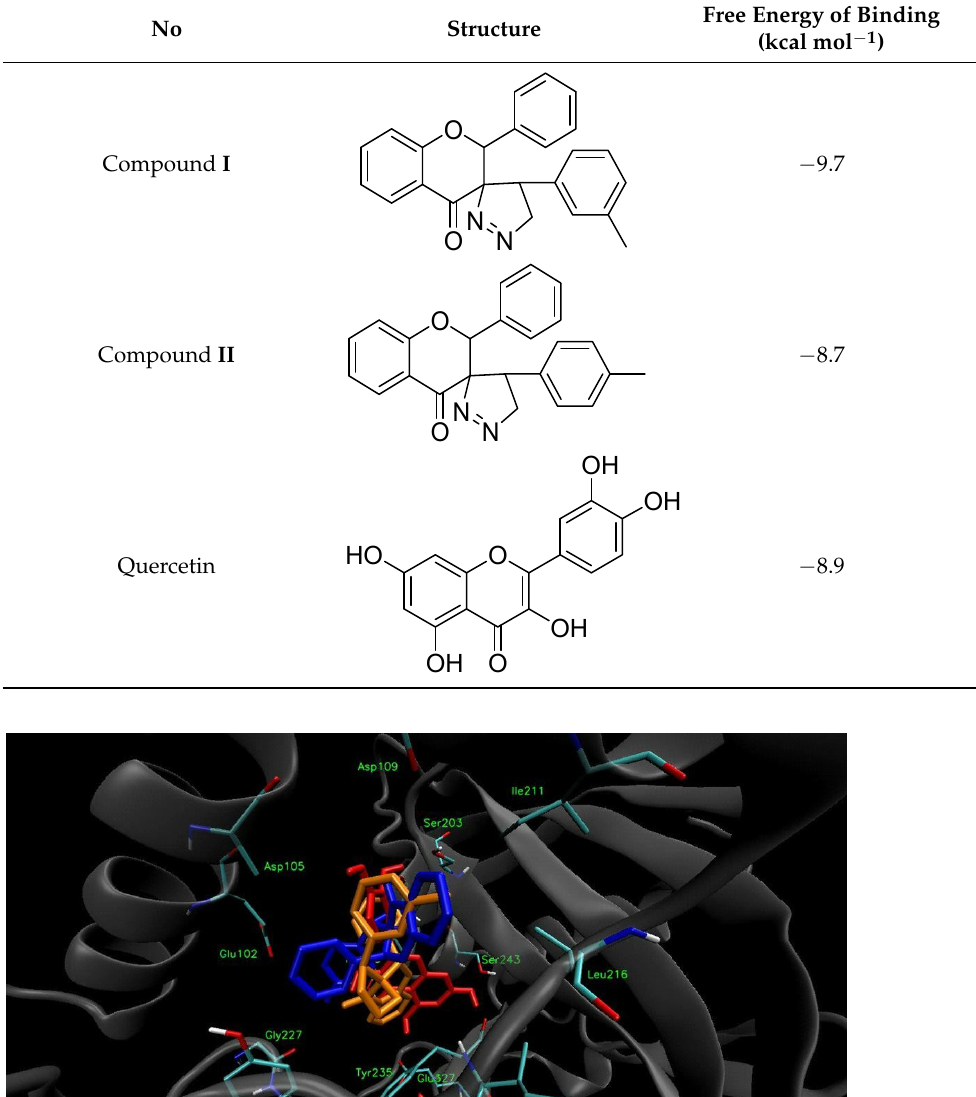
Table 2. Free energies of binding calculated for compounds I and II , and quercetin.